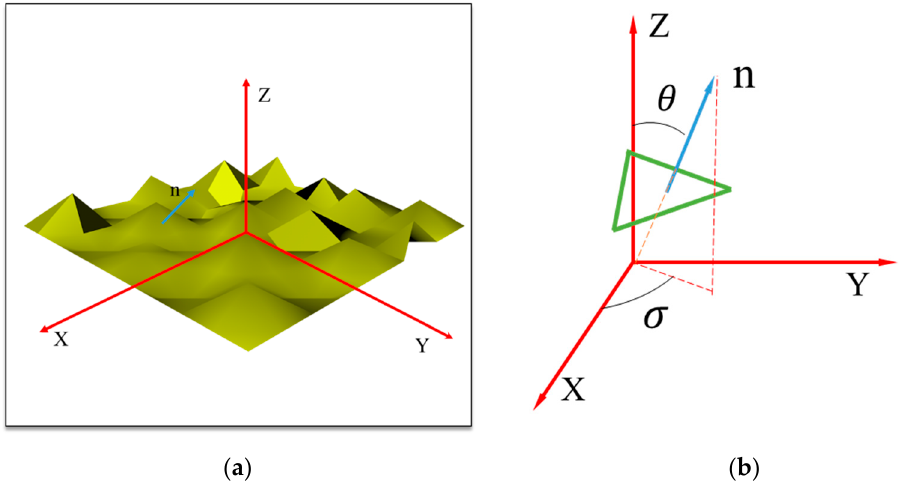
Figure 1. ( a ) Surface composed of the microfacets in the XYZ coordinate system, ( b ) the schematics of a single microfacet.